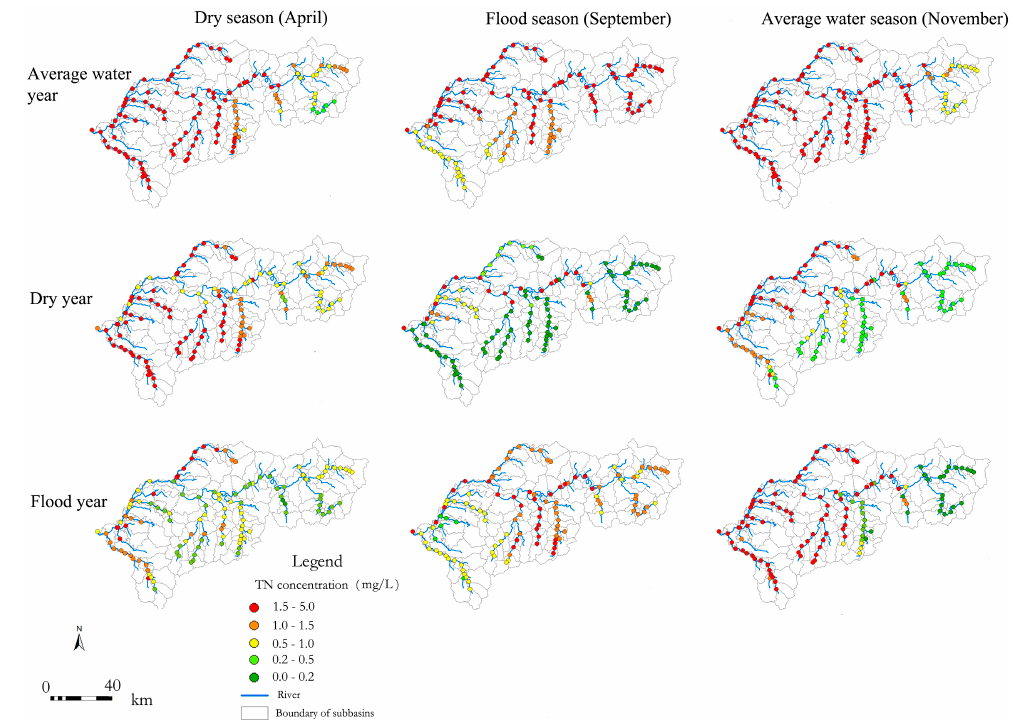
Figure 4. Temporal and spatial dynamics of TN concentration.